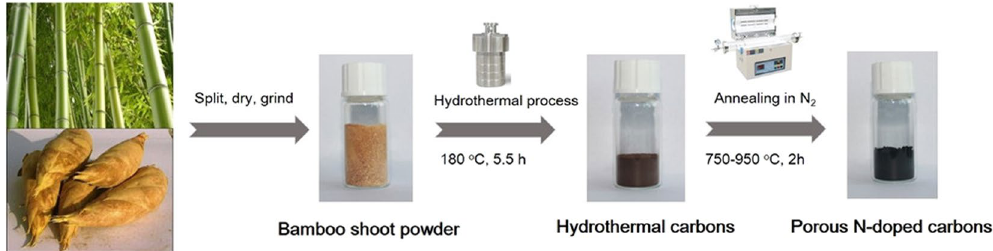
Figure 1. Schematic for the preparation of the porous N-doped carbon materials.